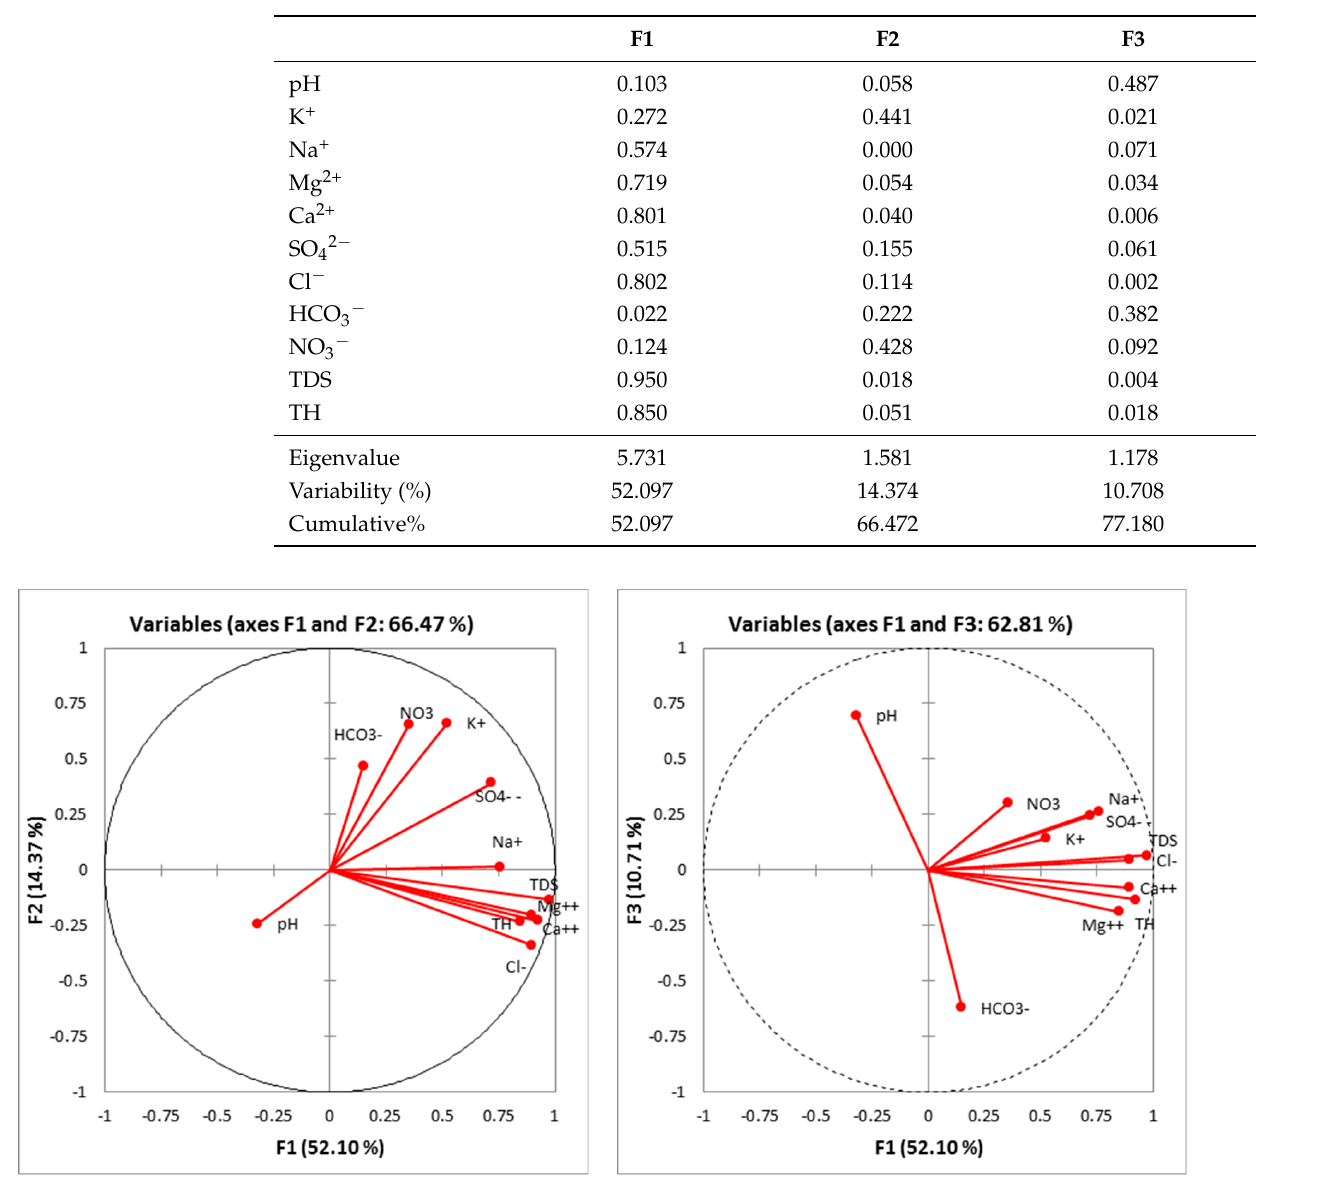
Figure 7. Biplot of F1 axis vs. F2 axis and F3 axis based on principal component analysis of sample element concentrations.